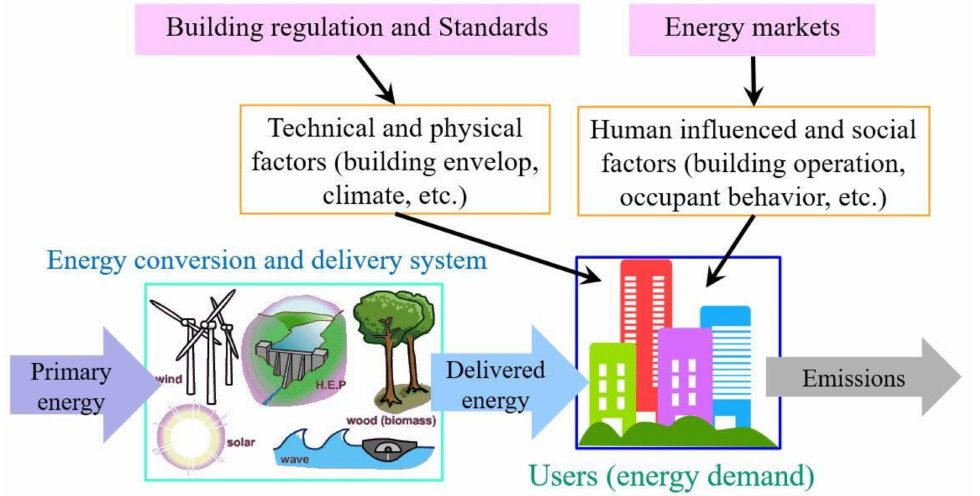
Figure 1. Big picture of urban building energy